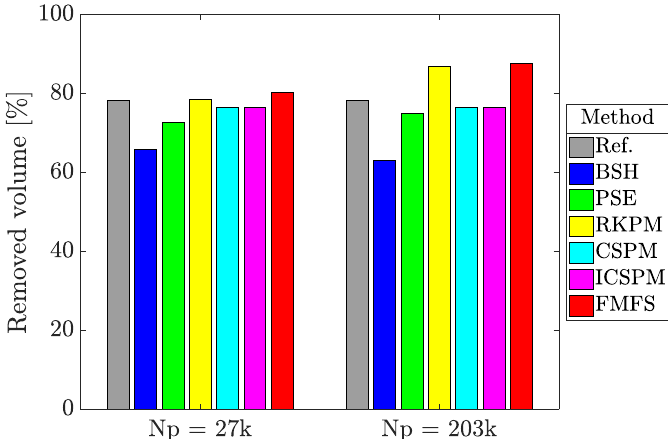
Figure 6. Bar-chart comparison of the removed volume in the present 3D models versus the 2D reference solution of [13]. The label N p indicates the total number of particles.